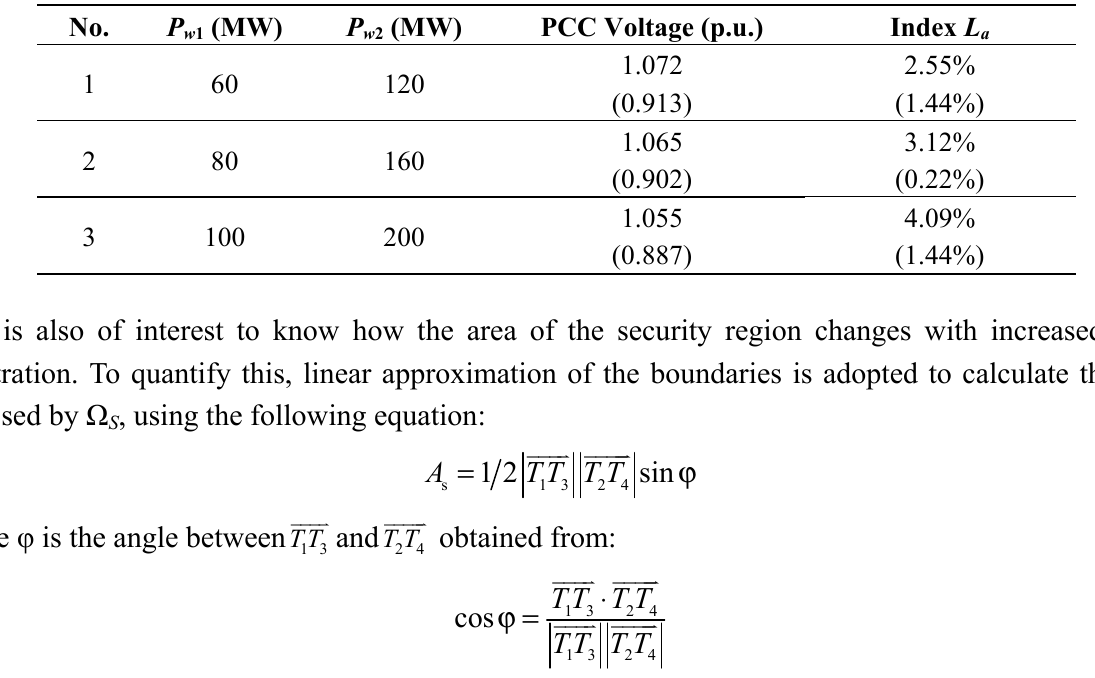
Table 1. PCC voltage and linearity index for different wind penetration levels.